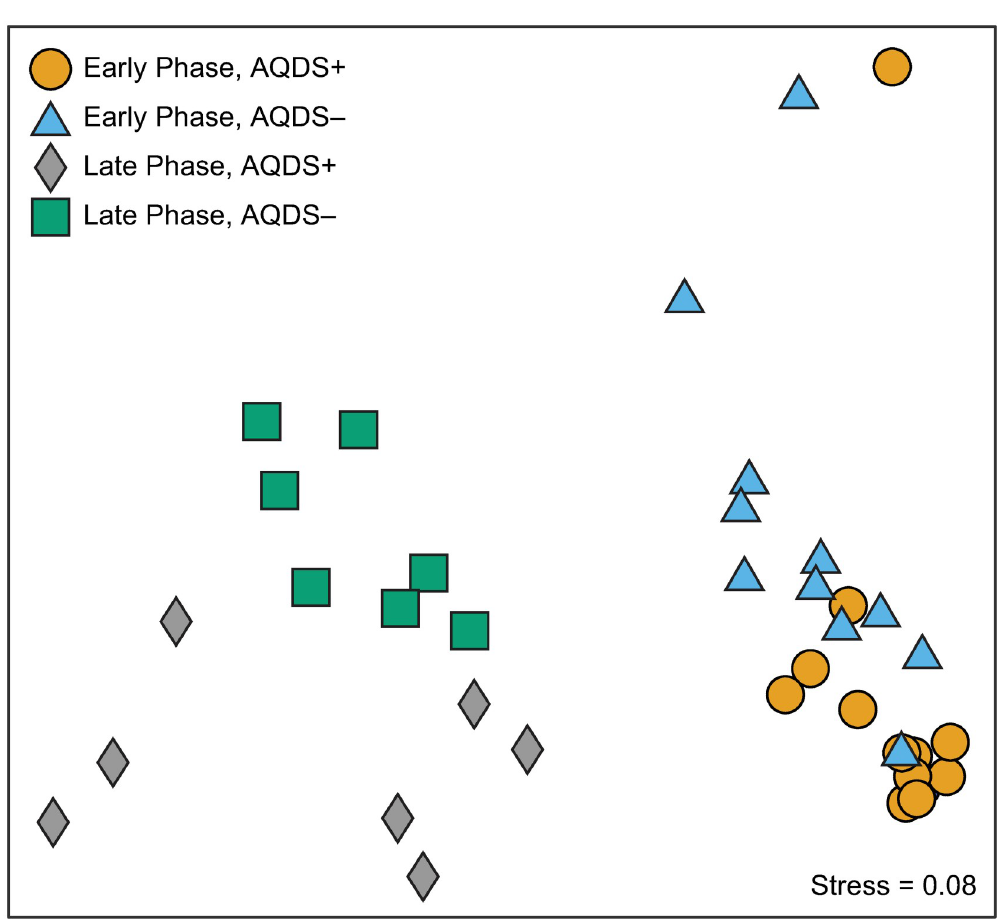
Fig 4. Nonmetric multidimensional scaling (NMDS) of microbial communities. Nonmetric multidimensional scaling (NMDS) of microbial communities in Fe III -, sulfate-, and acetate-amended bioreactors over time according to the presence (AQDS+) or absence (AQDS–) of the electron shuttle